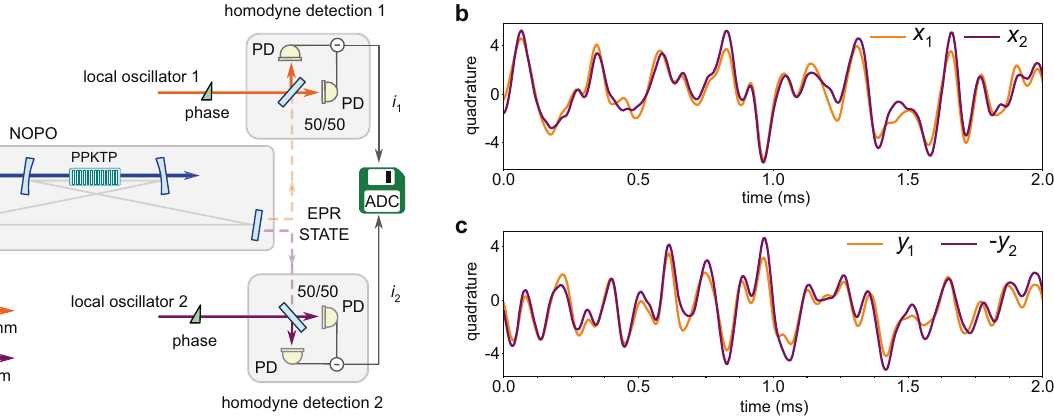
Fig. 1 | Experimental scheme and example of strong quadrature correlations. a Setup.The 852nm and 1064nm lasers produce the local oscillators and the blue light used to pump the NOPO through the sum-frequency generation. The corre- lated modes at the two colours emerging from the NOPO are separated with a dichroic mirror, mixed with the LOs, and measured by the homodyne detectors. Thephotocurrentsarerecordedbytheanalog-to-digitalconverter(ADC)toobtain